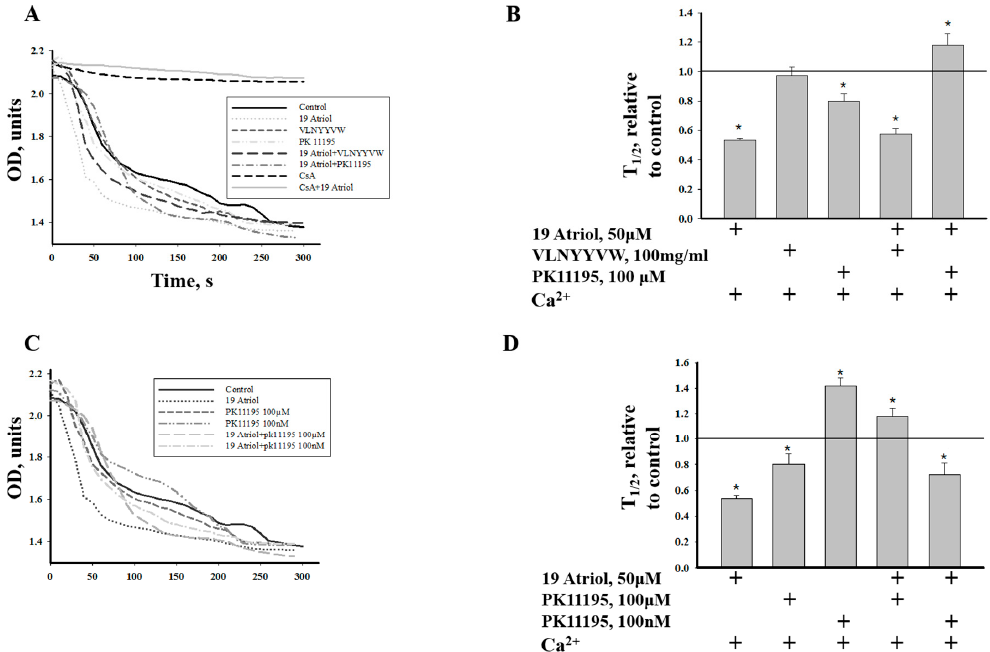
Figure 4. The effect of 19 ‐ Atriol, VLNYYVW, PK 11195, and the combined effect of 19 ‐ Atriol with VLNYYVW and PK 11195 on RLM swelling. A value of p < 0.05 was considered to be significant (asterisk indicates p < 0.05). ( A ) Curves of RLM swelling in the presence of 19 ‐ Atriol, VLNYYVW, and PK 11195 (100 µM). Trace 1 indicates the absence of swelling without Ca 2+ addition. Trace 8 demonstrates the absence of swelling in the presence of CsA; ( C ) Curves of RLM swelling in the presence of 19 ‐ Atriol, as well as in the presence of 19 ‐ Atriol in combination with different concentrations of PK 11195 (100 µM or 100 nM); ( B , D ) Average results of the half ‐ time (T 1/2) swelling, in comparison with the control swelling of RLM in the presence of Ca 2+ without any other additions. Lines in ( B ) and ( D ) show swelling of RLM under control